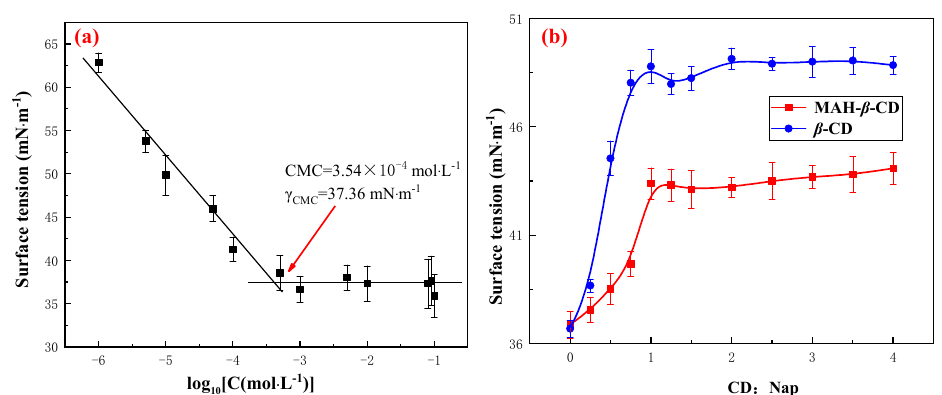
Figure 4. ( a ) Surface tension of NAP at 25 °C; ( b ) relationship between CD:NAP and NAP surface tension at 25 °C.